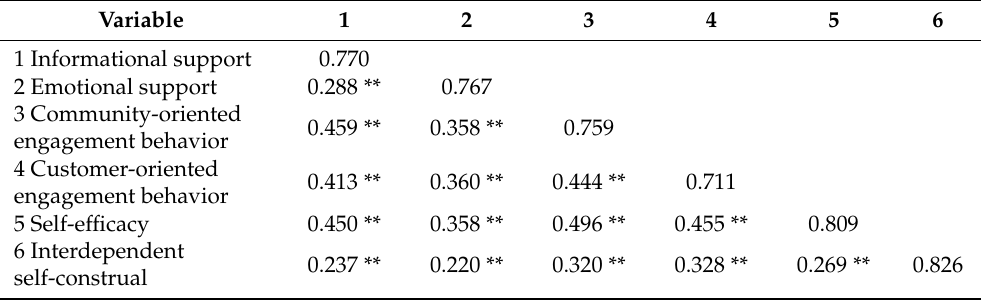
Table 3. Correlation of constructs and square root of